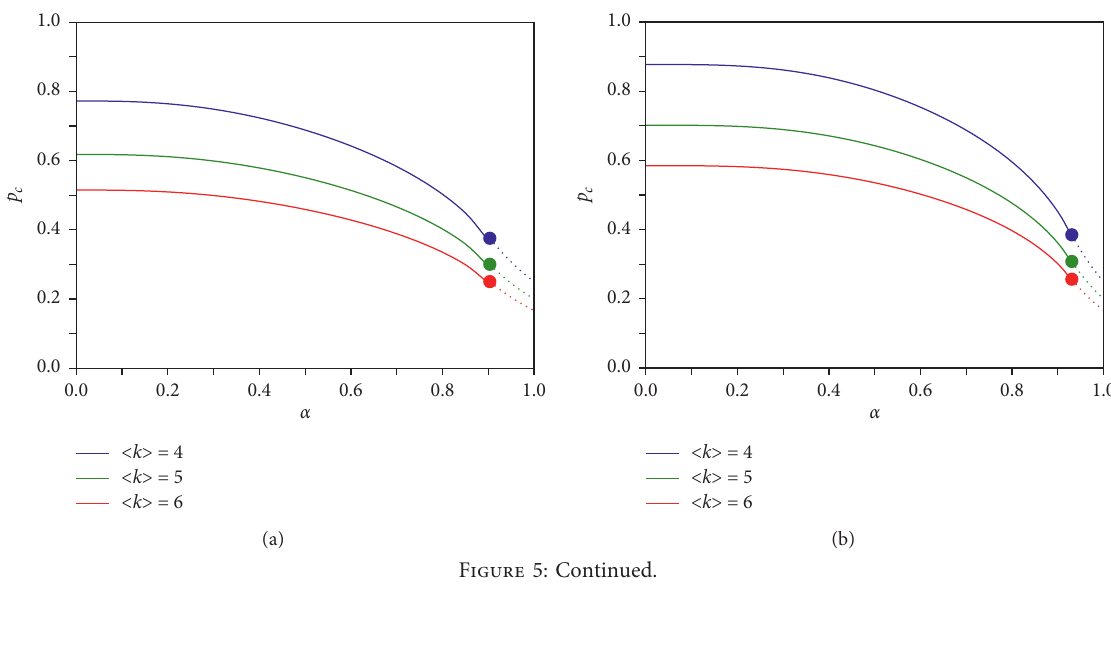
Figure 4: Simulation results for percolation transitions on three- and four-layer scale-free networks. (a), (b) The results for three- and four- layer scale-free networks with 〈 k 〉 � 4, respectively. (c), (d) The results for three- and four-layer scale-free networks with 〈 k 〉 � 5, re- spectively. When the average degree 〈 k 〉 � 4, the parameter settings for the power-law distribution are k When the average degree 〈 k 〉 � 5, the parameter settings are k averaging over 100 independent realizations, and the network size is N � 10 5 . The solid lines behind the symbols denote the theoretical predictions that were obtained by equations (1) and (2). The vertical dashed lines denote the first- and second-order percolation transition points predicted by equations (5) and (7),